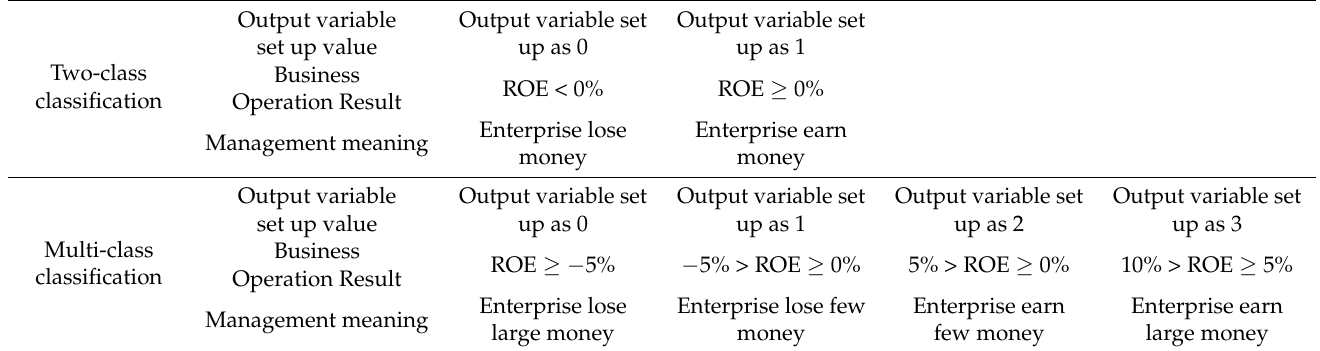
Figure 1. Execution process of the modified AdaBoost. Table 3. Output variable definition in the classification